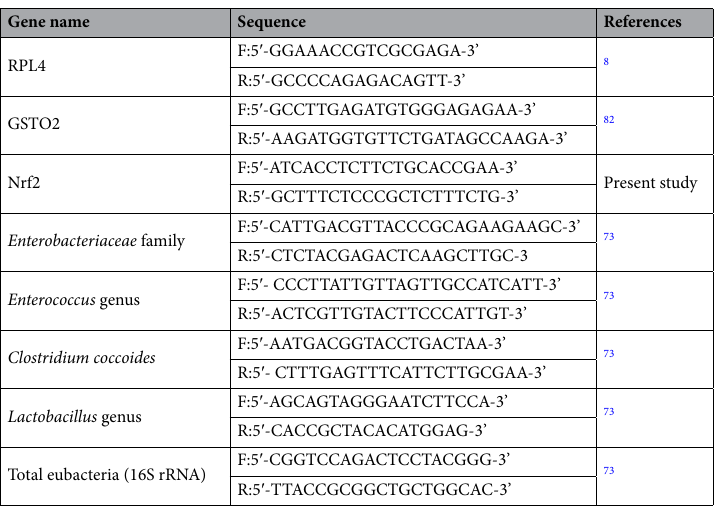
Table 2. The sequences of primers used in the present study. RPL4 ribosomal protein L4. GSTO2 glutathione S-transferase omega 2. Nrf2 nuclear factor erythroid 2-related factor